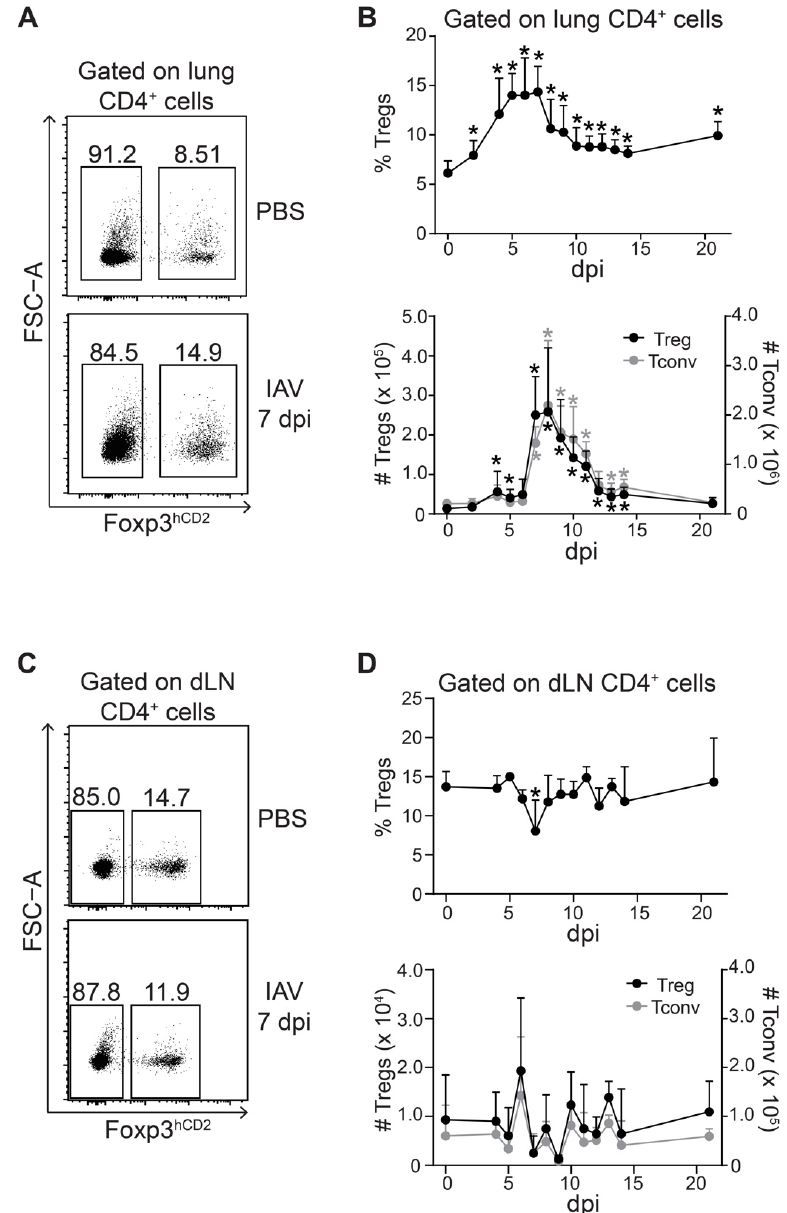
Figure 2. Peak of Treg accumulation coincides with that of Tconv in IAV-infected lungs. Foxp3 hCD2 × Rag1 GFP reporter mice were infected with IAV and analyzed at indicated dpi. Lungs and dLNs were collected and prepared, and single-cell suspensions were restimulated and subsequently ana- lyzed by flow cytometry; ( A ) Representative dot plots depict frequency of Foxp3 hCD2+ Tregs and Foxp3 hCD2- Tconv among CD4 + T cells in lungs of PBS-treated and IAV-infected mice (7 dpi); ( B ) Graphs summarize frequencies (top) and absolute numbers (bottom) of Tregs (black filled circles) and Tconv (gray filled circles); ( C ) Representative dot plots depict frequency of Foxp3 hCD2+ Tregs and Foxp3 hCD2- Tconv among CD4 + T cells in dLNs of PBS-treated and IAV-infected mice (7 dpi); ( D ) Graphs summarize frequencies (top) and absolute numbers (bottom) of Tregs (black filled circles) and Tconv (gray filled circles). Data were pooled from two to three independent experiments, which included 4–10 mice per group, and presented as mean + SD. Mann–Whitney test was used to calcu- late statistical significance by comparing values from untreated animals (for lung samples) or PBS- treated animals (for dLN samples) (0 dpi) with values from IAV-infected mice (2 to 21 dpi). Signifi- cant changes are indicated by an asterisk.